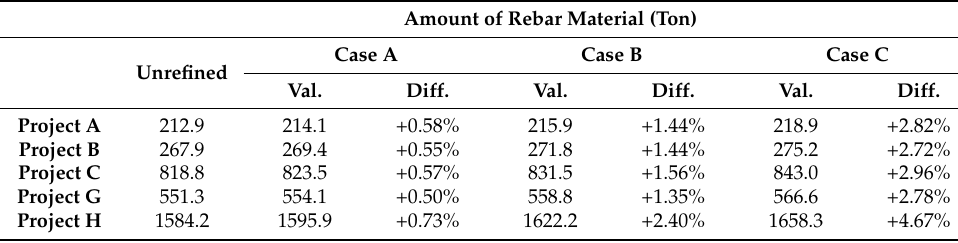
Table 5. Amounts of Rebar Materials for Beam Members and Differentials by Cases.